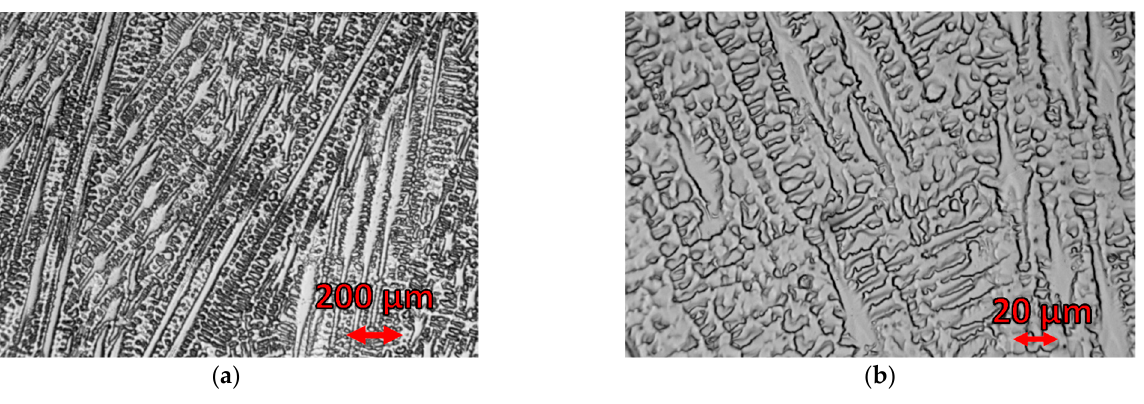
Figure 10. The microstructure of the mixed joint ( a ) central part made of S355J2W+N steel and Alloy 59. ( b ) enlargement of the selected area shown in ( a ).